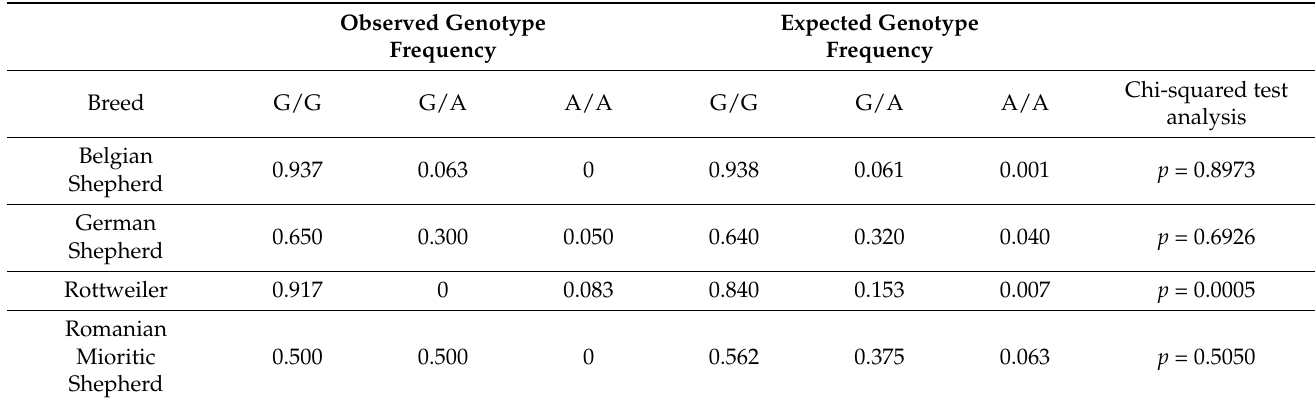
Table 2. Hardy–Weinberg equilibrium test